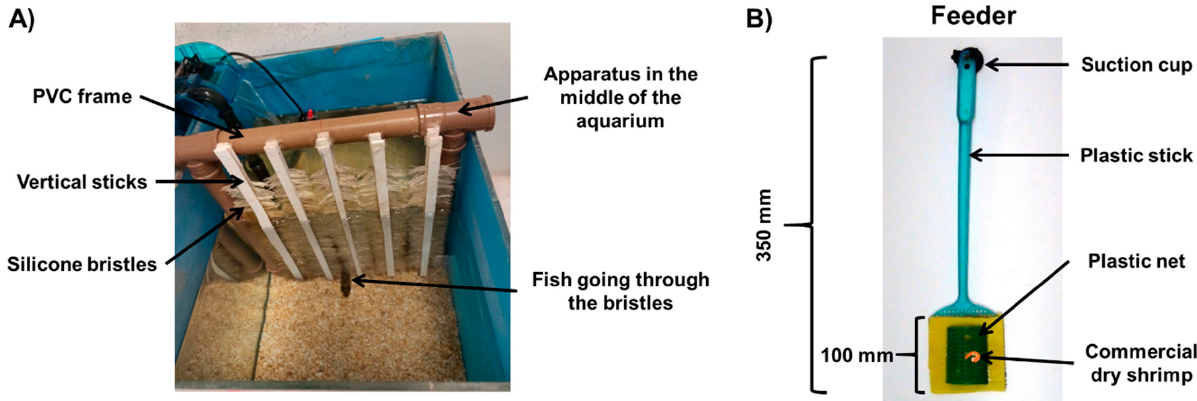
Figure 1. Tactile stimulation device. ( A ) Tactile stimulation device placed centrally in the aquarium with a fish going through the tactile bristles. ( B ) The feeder that was used to stimulate fish to go through the tactile device during the exposure phase.